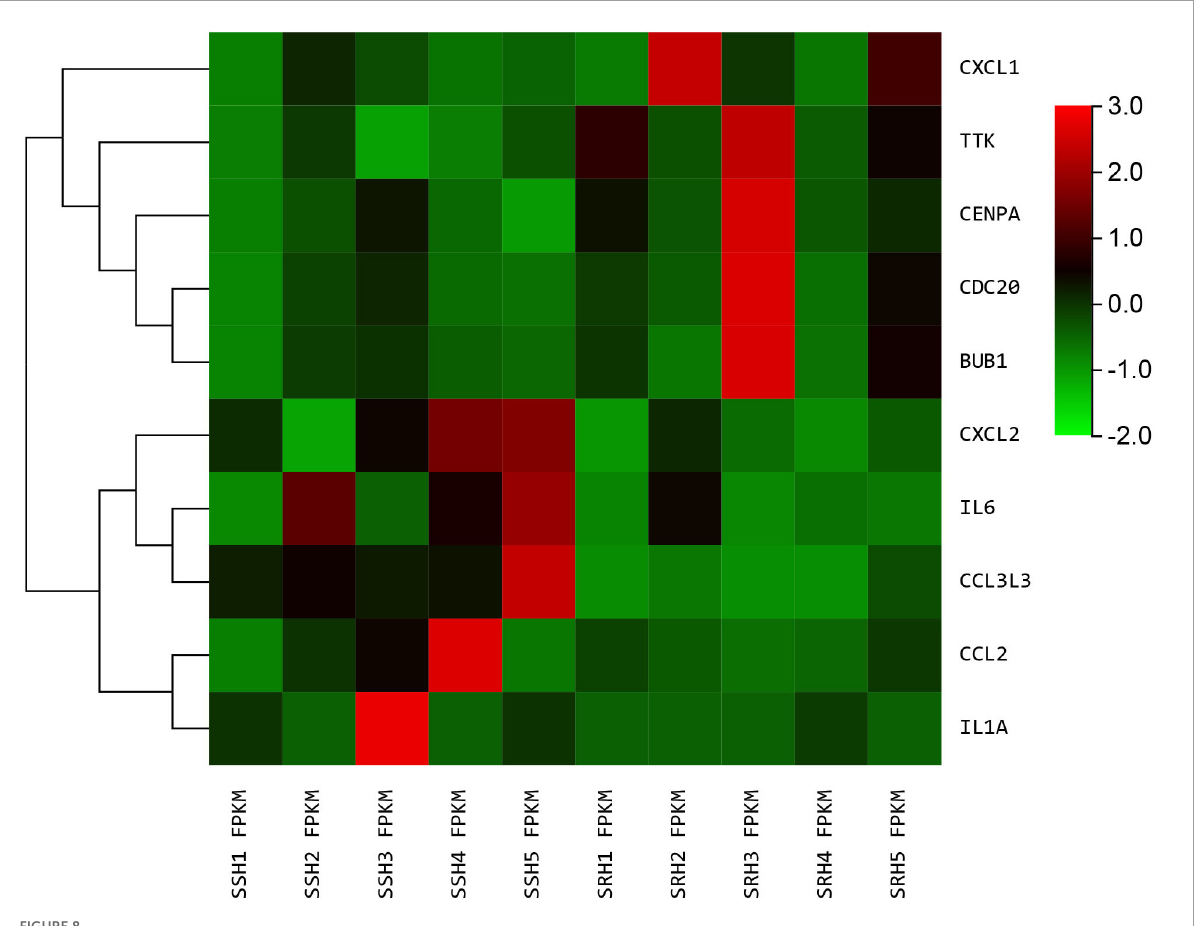
FIGURE8 The heatmap of hub genes. Color from green to red indicated low to high representation value.